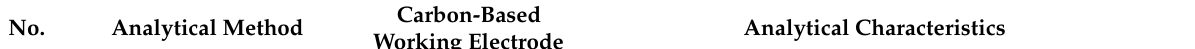
Table 3. Some relevant examples of electrochemical assay of antioxidant activity and its key contributors [173–205]. Carbon-Based No. Analytical Method Analytical Characteristics Working Electrode